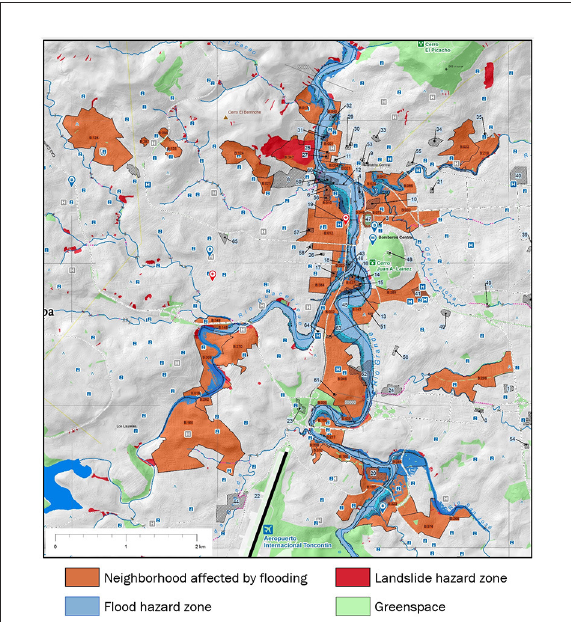
FIGURE2 Flood hazard map for the Choluteca River in Tegucigalpa. Blue depicts flood hazards projected for different rainfall events and risk scenarios. Red depicts landslide hazards along the river that can exacerbate flooding. Amber depicts neighborhoods historically affected by and which must be prepared for flood hazards. Key local resources relevant to flood risk preparedness and response including hospitals, schools, and meteorological monitoring stations are also marked on the map. Credit: